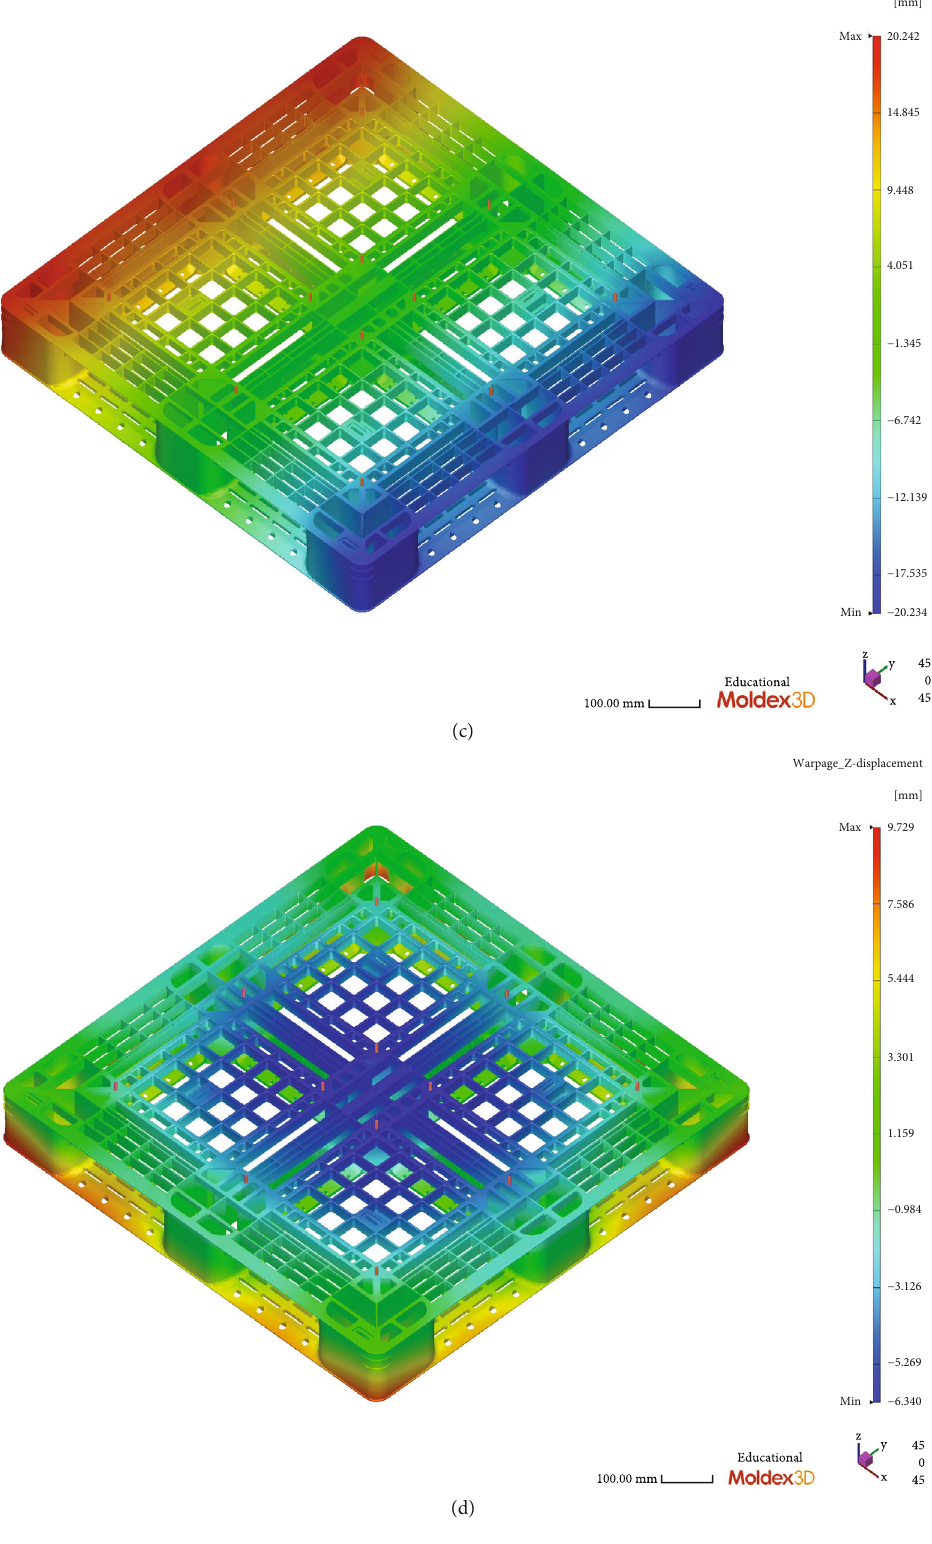
Figure 10: Warpage deformations of plastic pallet. (a) x -axial deformation by concurrent valve gate opening scheme (-20.530 ~ 20.538mm). (b) z -axial deformation by concurrent valve gate opening scheme (-6.444 ~ 10.906mm). (c) x -axial deformation by sequential valve gate opening scheme (-20.234 ~ 20.242mm). (d) z -axial deformation by sequential valve gate opening scheme (-6.34 ~